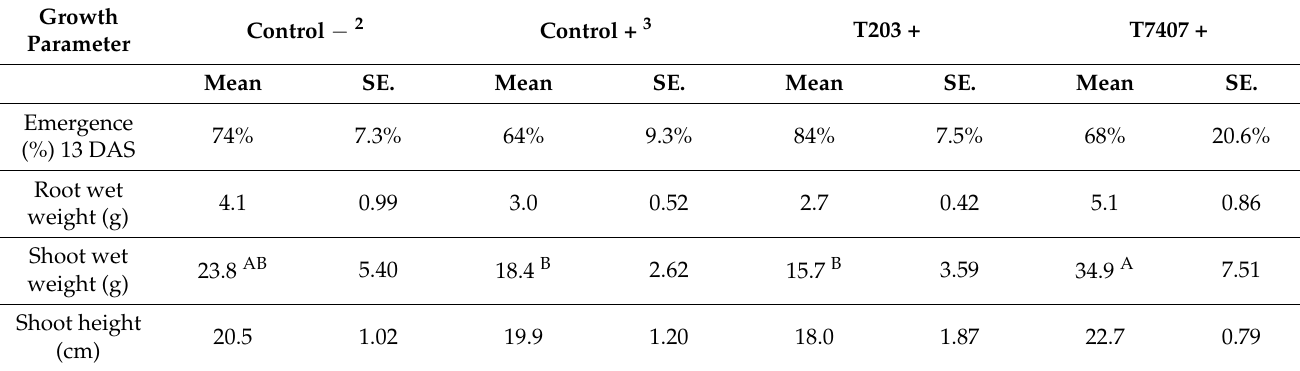
Table 4. Trichoderma spp. influence in pots under field conditions, at the sprouting phase 1